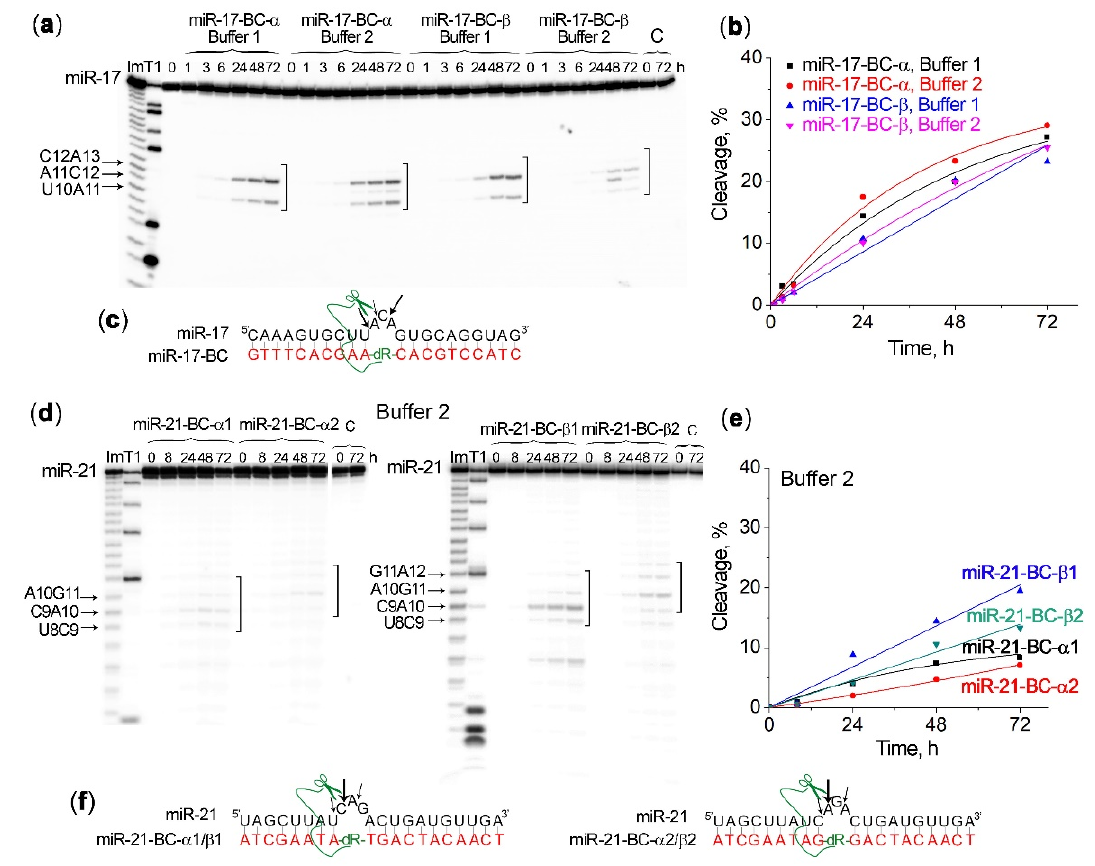
Figure 3. Kinetics of 5 ′‐ [ 32 P] ‐ miR ‐ 17 and 5 ′‐ [ 32 P] ‐ miR ‐ 21 cleavage by mono ‐ conjugates miR ‐ 17–BC ‐α , miR ‐ 17–BC ‐β , miR ‐ 21–BC ‐α 1, miR ‐ 21–BC ‐α 2, miR ‐ 21–BC ‐β 1, and miR ‐ 21–BC ‐β 2. ( a , d ) Radioauto ‐ graphs of 18% denaturing PAAG showing the cleavage products of miR ‐ 17 in Buffer 1 and Buffer 2 and miR ‐ 21 in Buffer 2. miRNA (1 μ M) and BCs (20 μ M) were incubated at 37 °C for 72 h. Lanes Im and T1: imidazole ladder and partial RNA digestion with RNase T1, respectively; C: control, miRNA was incubated in the absence of conjugates. The incubation time (in hours) is shown at the top. The square bracket indicates the bulge ‐ loop region. ( b , e ) Progress curves of miR ‐ 17 and miR ‐ 21 cleavage by BCs. ( c , f ) Positions of miR ‐ 17 cleavage by miR ‐ 17–BC ‐α / β and miR ‐ 21 cleavage by miR ‐ 21–BC ‐α 1/ β 1 and miR ‐ 21–BC ‐α 2/ β 2, respectively. The size of the arrows corresponds to the extent of miRNA cleavage at the particular linkage.